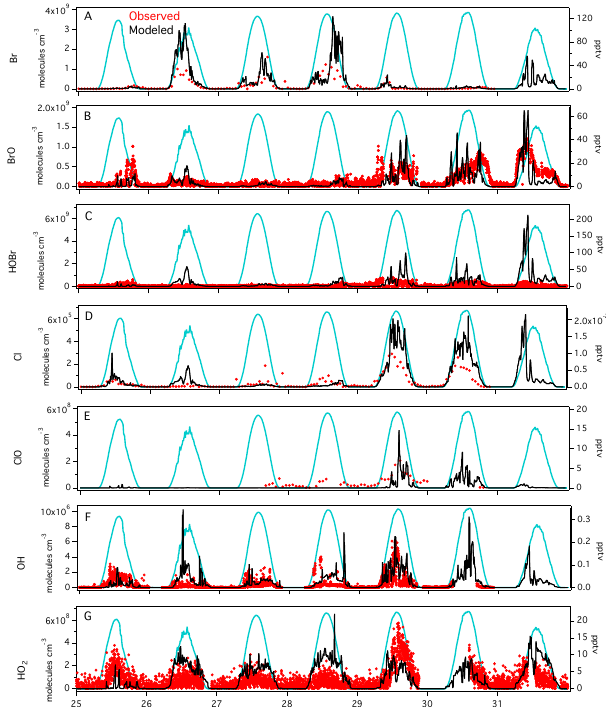
Figure 2. Modeled (black) compared to observed (red) time series for BrO, HOBr, ClO, OH, and HO 2 . Modeled Br and Cl (black) are compared to steady-state approximations as calculated in Stephens et al. (2012) (red). All concentrations are shown in moleculescm − 3 on the left axis and as mole ratios in pptv on the right axis. Radia- tion is shown as the cyan trace as a reference. Time is expressed in Alaska Standard